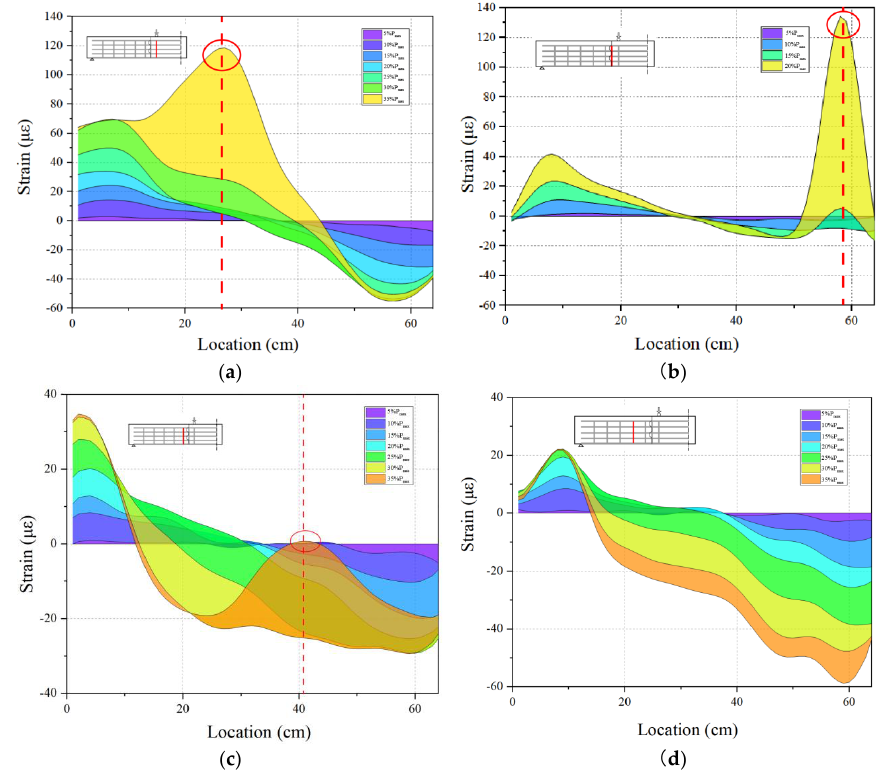
Figure 9. Strain profile, along cross-section depth, under ascending load for the segmental beam cap: ( a ) Section 1 (7 in Figure 4); ( b ) Section 2 (6 in Figure 4); ( c ) Section 3 (5 in Figure 4); ( d ) Section 4 (4 in Figure 4).